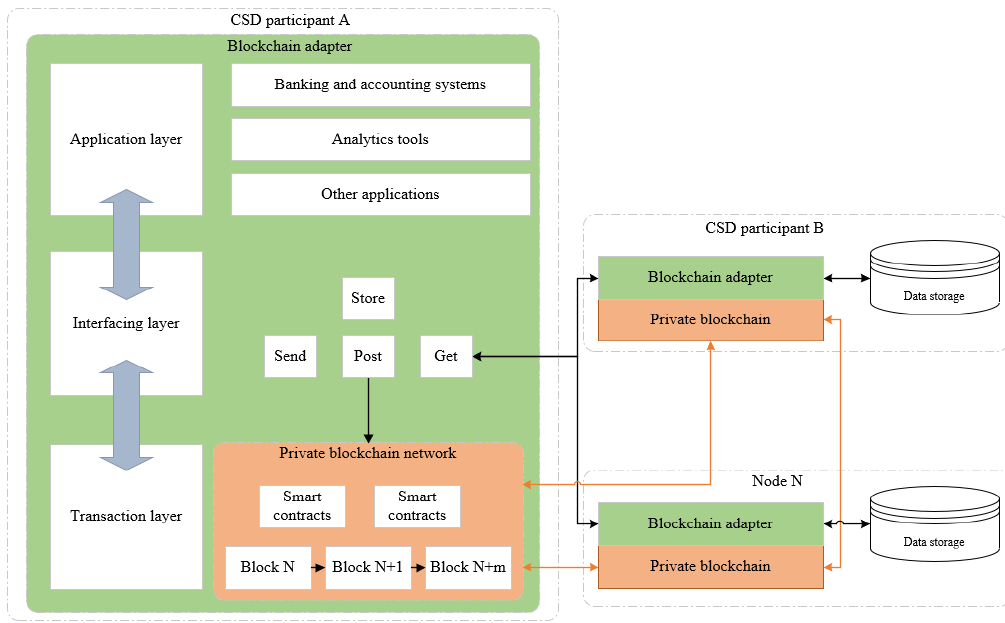
Figure 3. Layered blockchain architecture model for securities settlement (available also in